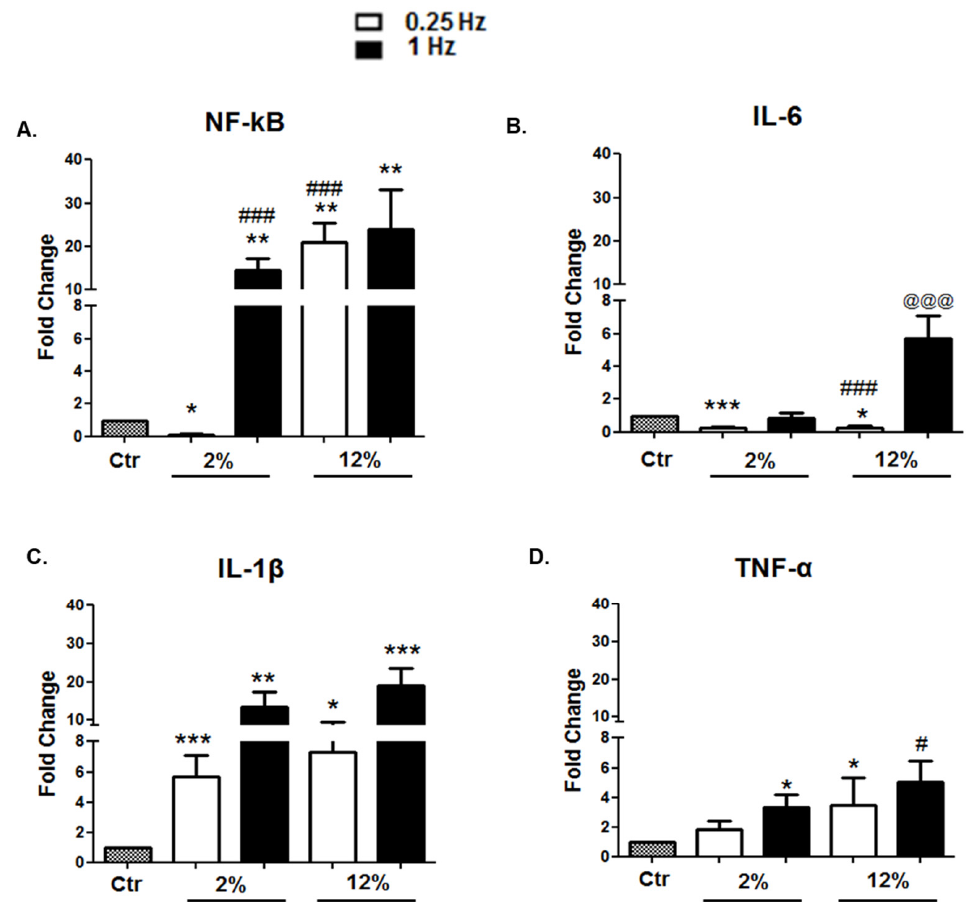
Figure 6. ( A – D ) Effects of mechanical loading on the expression of pro-inflammatory factors. Quantitative analysis of ( A ) NF-kB, ( B ) IL-6, ( C ) IL-1 β , and ( D ) TNF- α transcriptional responses of differentiated cardiomyocytes subjected to various mechanical stretching protocols compared to the control (Ctr; nonstretched myotubes). The mRNA values of inflammation-related factors in stretched myotubes have been normalized to the corresponding GAPDH mRNA and are expressed as fold changes compared to the control. Significantly different compared to the control, * p < 0.05; ** p < 0.01; *** p < 0.001. Significantly different compared to 2%/0.25 Hz stretching protocol, # p < 0.05; ### p < 0.001. Significantly different compared to the 12%/0.25 Hz stretching protocol, @@@ p < 0.001. Mean + SE of three independent experiments performed in triplicate.